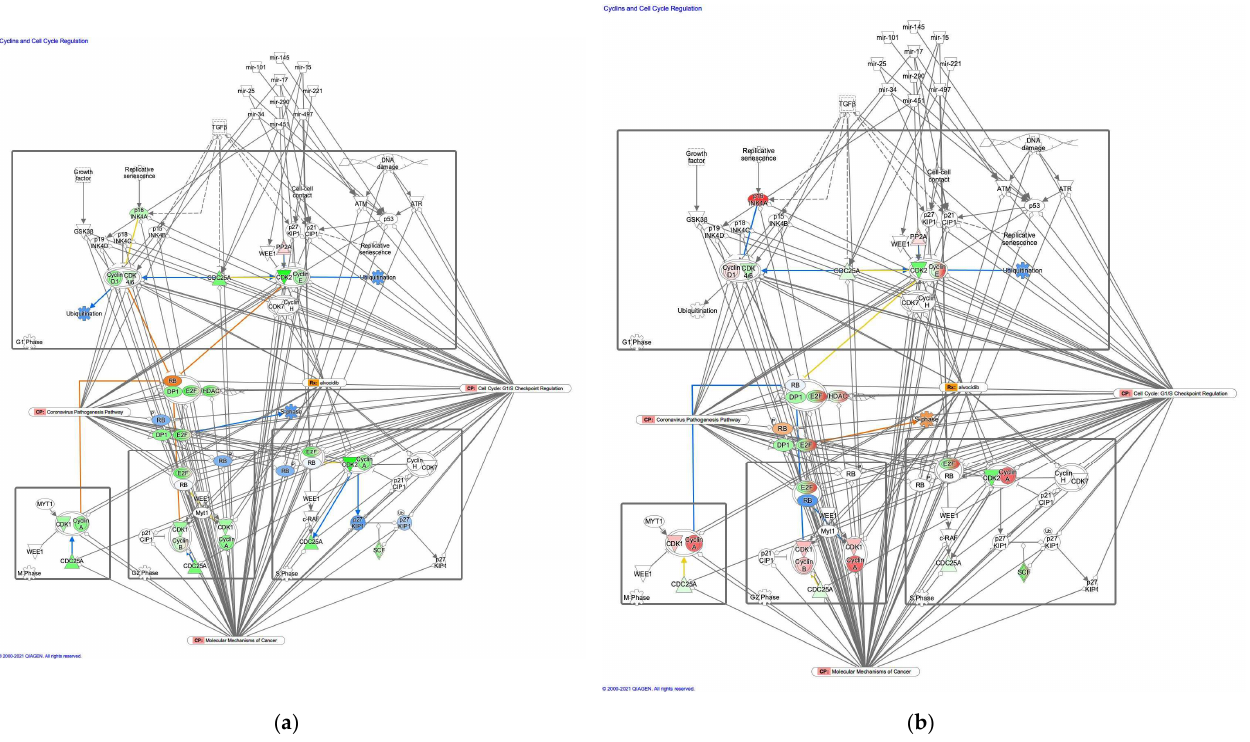
Figure 4. The cyclin and cell cycle regulation pathway was activated in intestinal-type GC. ( a ) Gene expression and pathway activity predictions in diffuse-type GC are shown. ( b ) Gene expression and pathway activity predictions in intestinal-type GC are shown. The genes whose expression was altered in diffuse- and intestinal-type GC are shown in pink (upregulated) or green (downregulated). Predicted activation and inhibition are shown in orange and blue, respectively. Table 4. Direct relationships of miRNAs and targeted molecules in cyclin and cell cycle regulation.